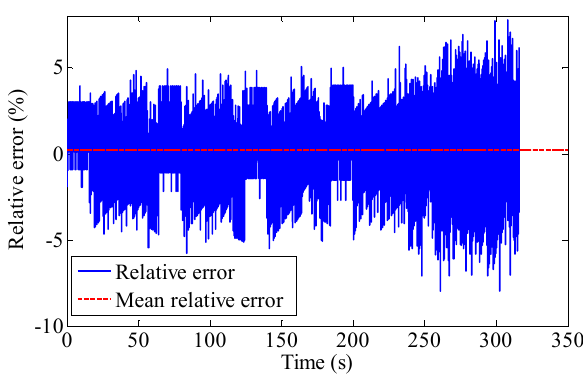
Figure 7. The relative voltage error in the DST test.